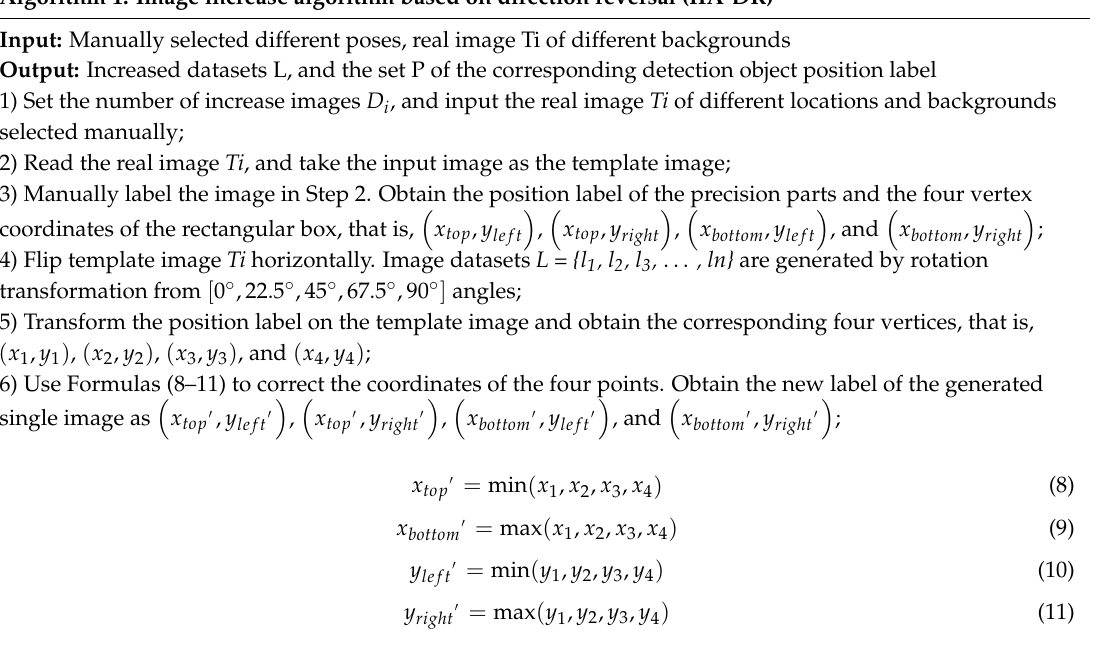
Algorithm 1: Image increase algorithm based on direction reversal (IIA-DR)